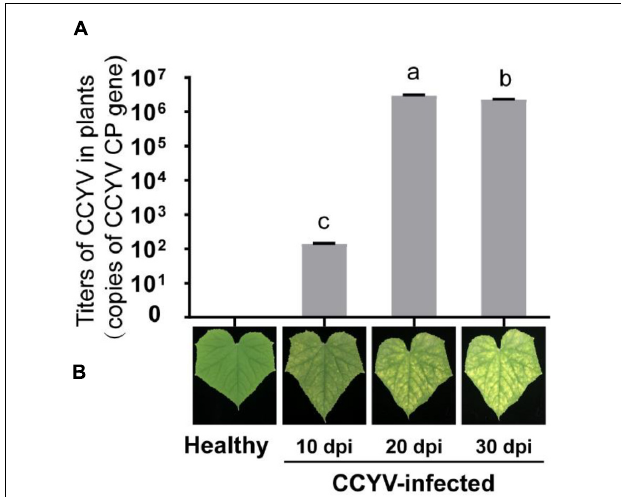
FIGURE 2 | Virus titers (A) and symptoms (B) in CCYV-infected plants at different stages. Virus titers in CCYV-infected cucumber leaves on 10, 20, and 30 dpi were detected by qRT-PCR. Columns show mean ± standard error. Y-axis represents the copies of the CCYV coat protein gene. Differences among incubation periods were analyzed by a one-way ANOVA. Means with the same letter were not significantly different ( p <